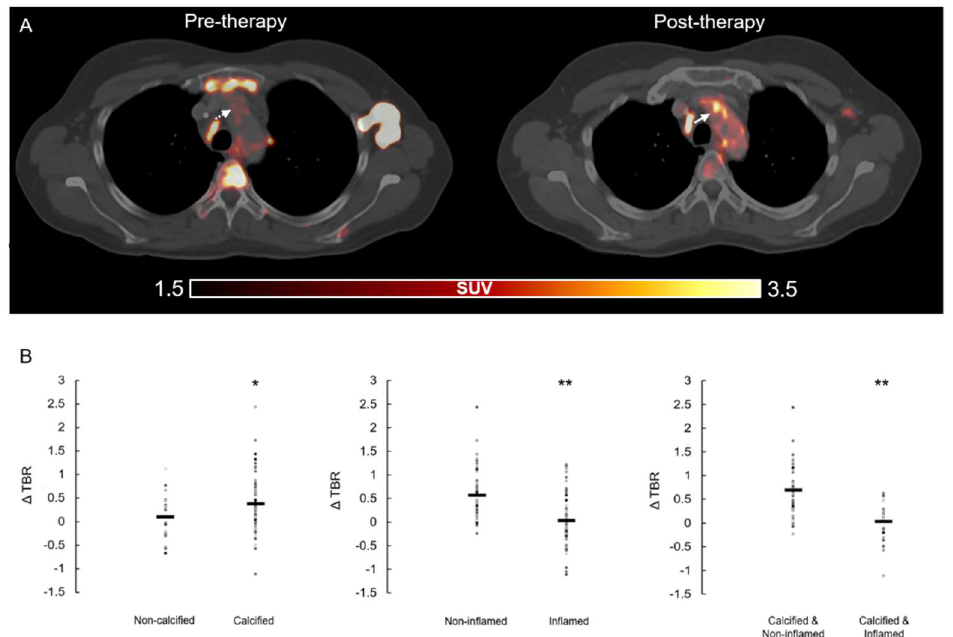
Figure 1. ( A ) . Representative PET/CT images. Increased arterial FDG uptake (white arrow) after ICI therapy compared to baseline examination (pre-therapy). PET, positron emission tomography; CT, computer tomography; FDG, 2-[ 18 F]fluorodeoxyglucose; ICI, immune checkpoint inhibitors. ( B ). Change in inflammatory activity (ΔTBR) in arterial segments. Given four subgroups with/without calcification as well as pre-existing/absent active inflammation (cut-off: TBRpre = 1.48). TBR, target-to-background ratio. * Significance of p < 0.05, ** significance of p < 0.001.